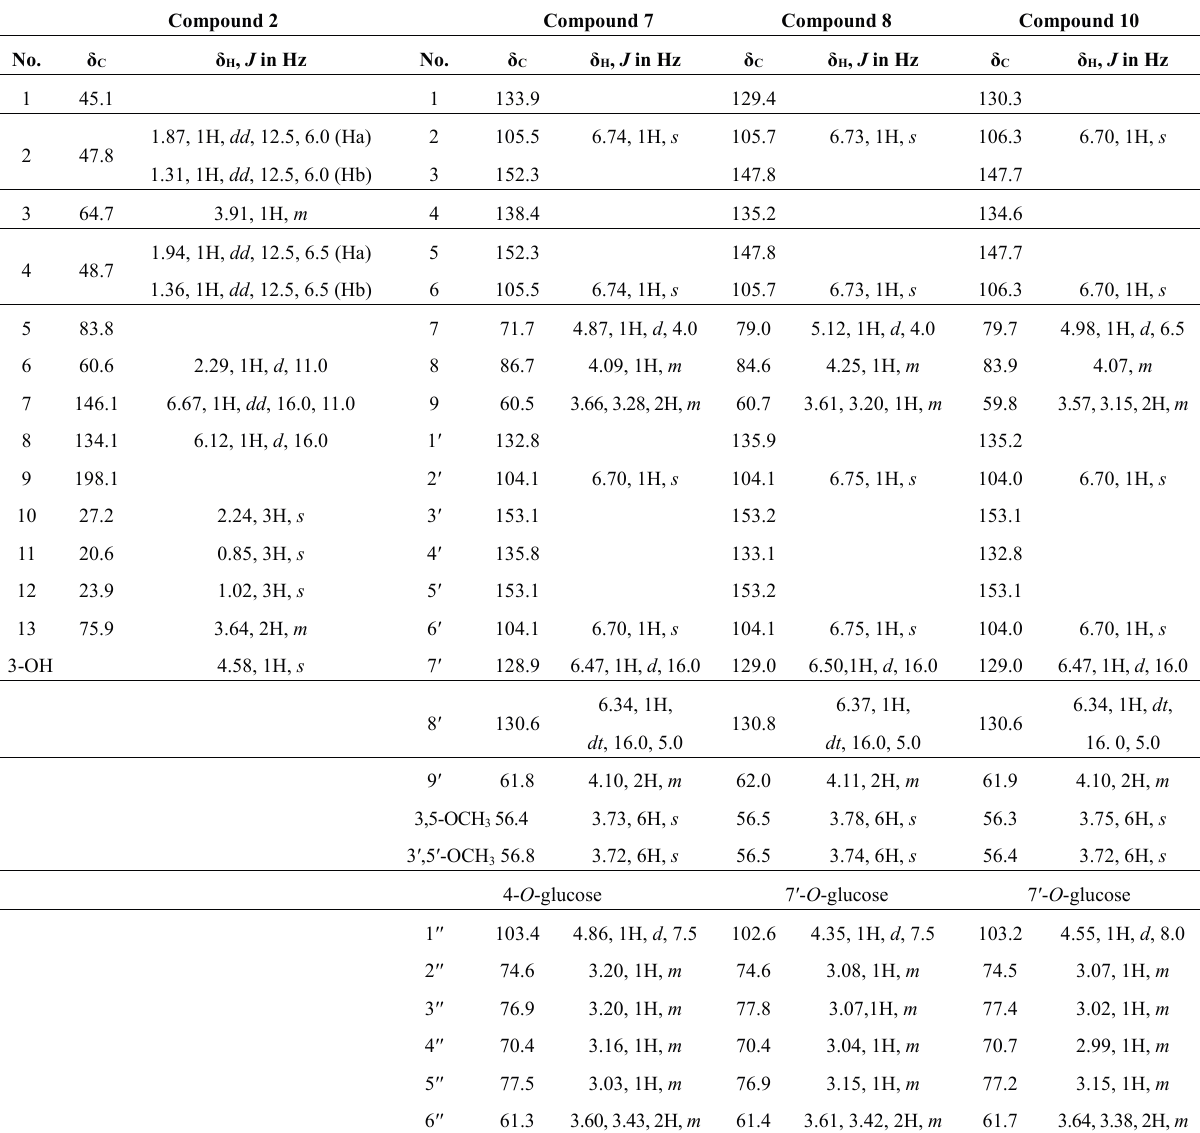
Table 1. NMR spectroscopic data (measured at 500 MHz) of the isolated compounds 2 , 7 , 8 , and 10 in DMSO from the leaves of Indocalamus latifolius McClure. Compound 2 Compound 7 Compound 8 Compound